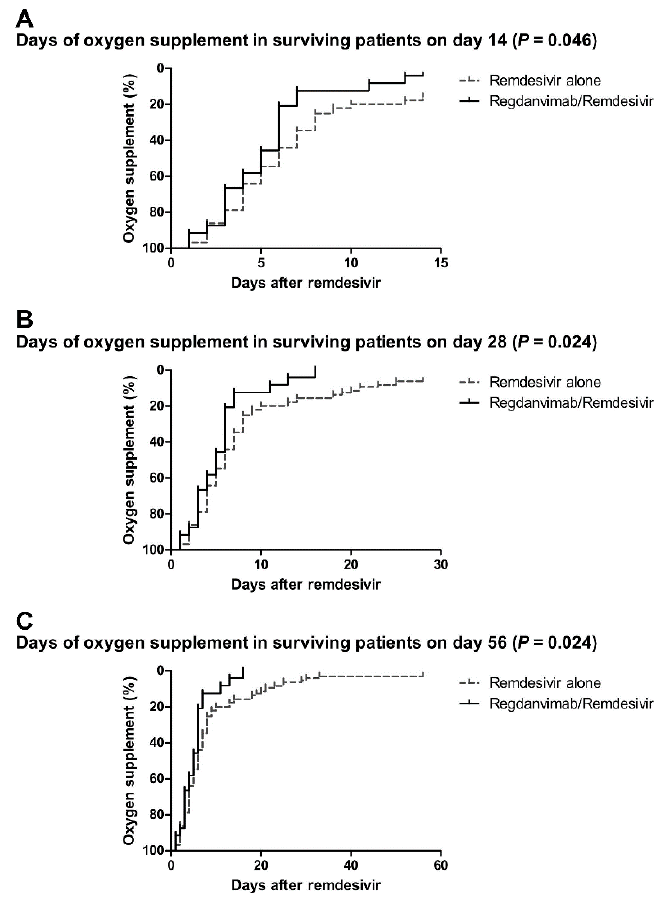
Figure 2. Kaplan-Meier estimates of the remdesivir alone and regdanvimab/remdesivir groups. ( A ) Days of oxygen supplementation, in surviving patients on day 14, were shorter in the regdanvimab/remdesivir group (days, mean ± SD: 6.71 ± 4.18 vs. 5.20 ± 3.43, p = 0.046). ( B ) Days of oxygen supplementation, in surviving patients on day 28, were shorter in the regdanvimab/remdesivir group (days, mean ± SD: 8.24 ± 7.43 vs. 5.28 ± 3.66, p = 0.024). ( C ) Days of oxygen supplementation, in surviving patients on day 56, were shorter in the regdanvimab/remdesivir group (days, mean ± SD: 9.31 ± 11.41 vs. 5.28 ± 3.66, p = 0.024). Abbreviations: SD, standard deviation. Table 3. Factors associated with oxygen-free days on day